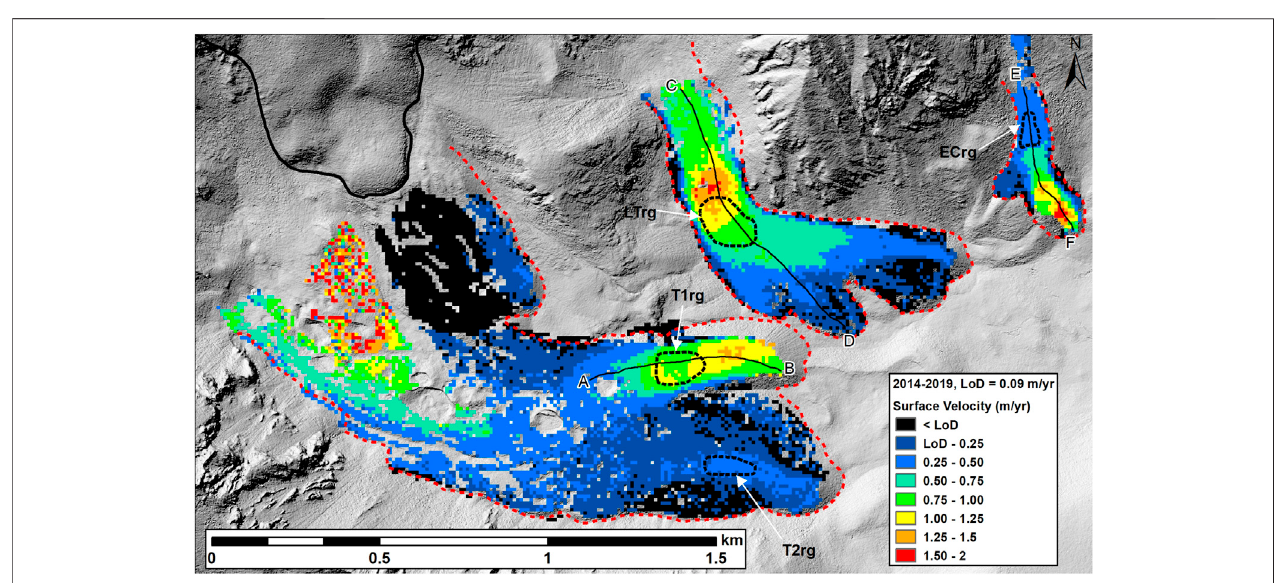
FIGURE 5 | Surface velocities of the three investigated units between 2014 and 2019. Black lines and labels (A – F) indicate the surface velocity pro fi les ( Figure 6 ). Whitearrows indicate thefourzones (black dashed outlines)where thetime series(1956 – 2019)ofsurfacekinematicswerecompiled ( Figure7 ).The backgroundimage corresponds to a Pléiades-derived hillshade from January 2019. CNES (2018), and Airbus DS (2018), all rights reserved.